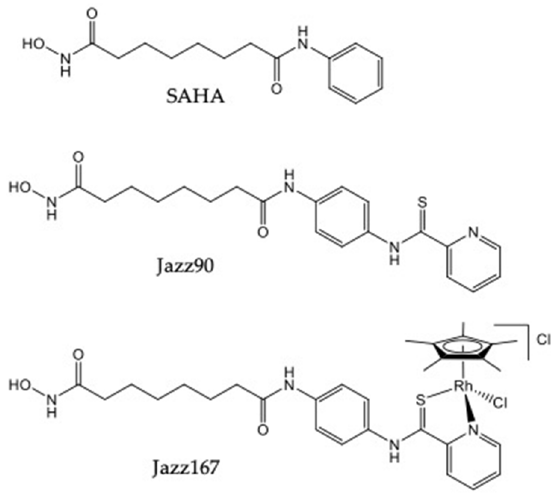
Figure 1. Structures of SAHA, Jazz90 and